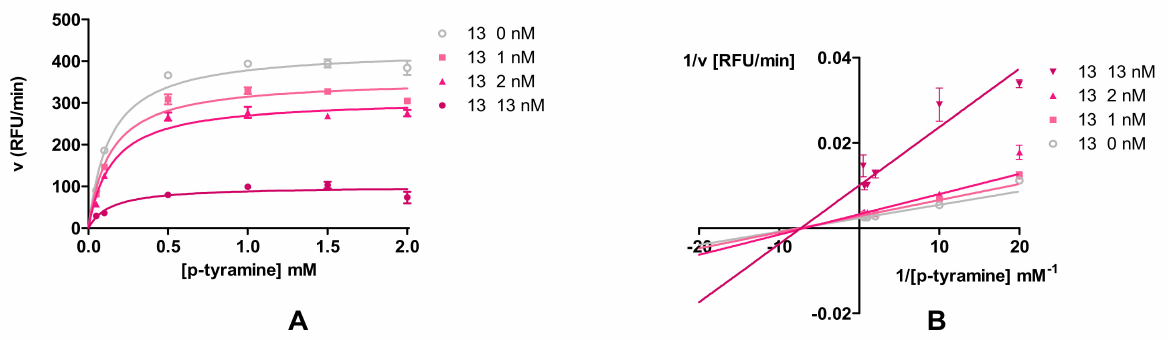
Figure 4. Michaelis–Menten curves ( A ) and Lineweaver–Burk ( B ) plot for 13 . Compound showed noncompetitive inhibition with equal affinity to the free enzyme and enzyme-substrate complex.